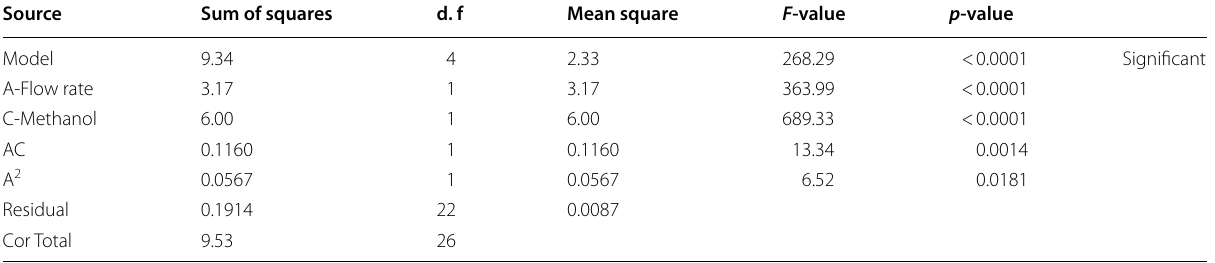
Table 5 ANOVA results for Response 1: RT